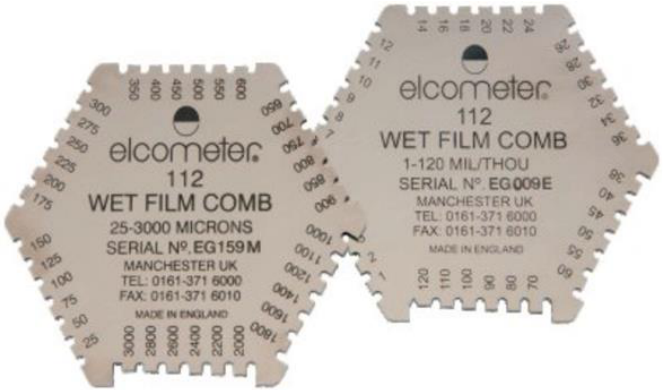
Figure 6. Elcometer 112Al.